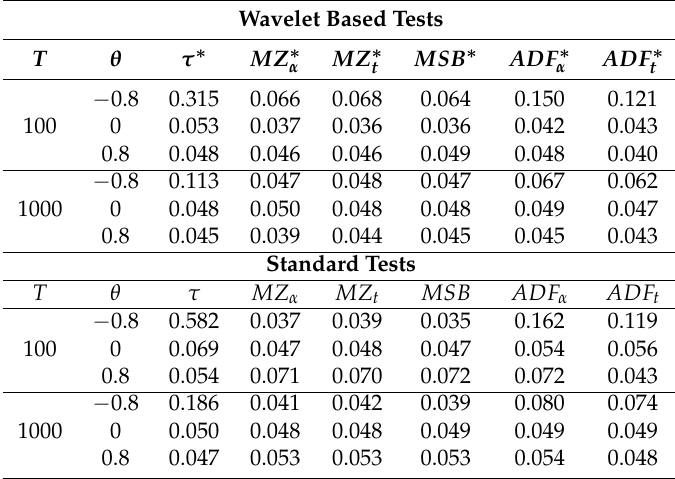
Table 4. The size comparison of the standard and wavelet based unit root tests under GLS